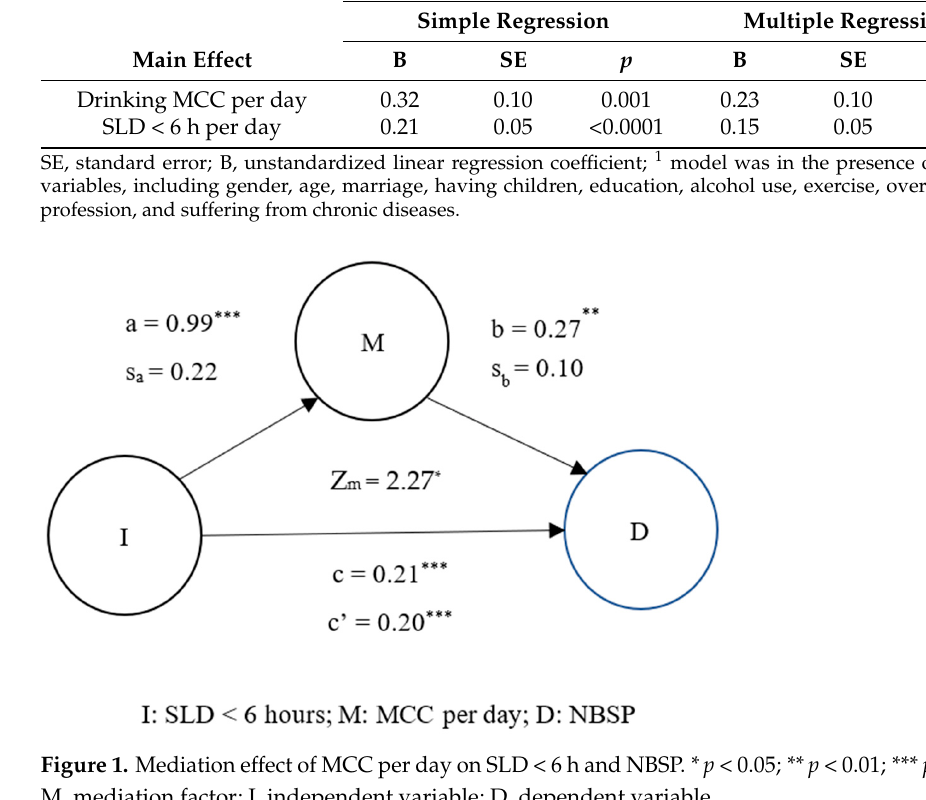
Table 3. Effect of SLD and drinking MCC per day on NBSP. Unstandardized Linear Regression Coefficient (B) for NBSP Simple Regression Multiple Regression 1 Main Effect